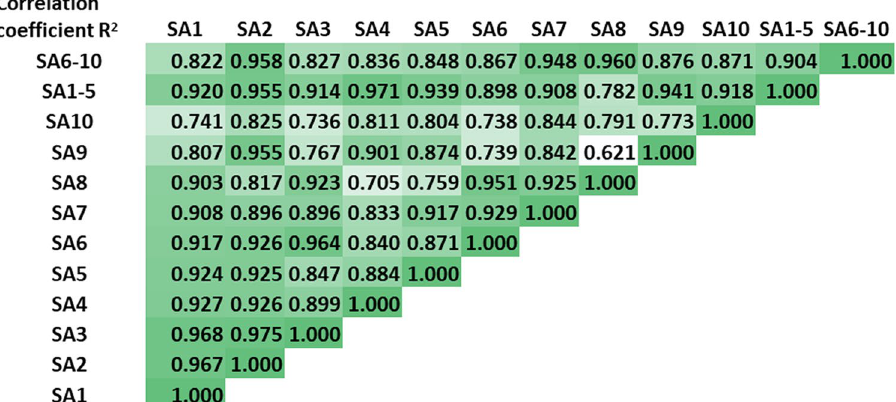
Figure 6. Accuracy and reproducibility of the quantitative proteomics analyses A. correlated protein expression across sample (SA) replicates 1 through 10 and pooled samples (SA1-5 and